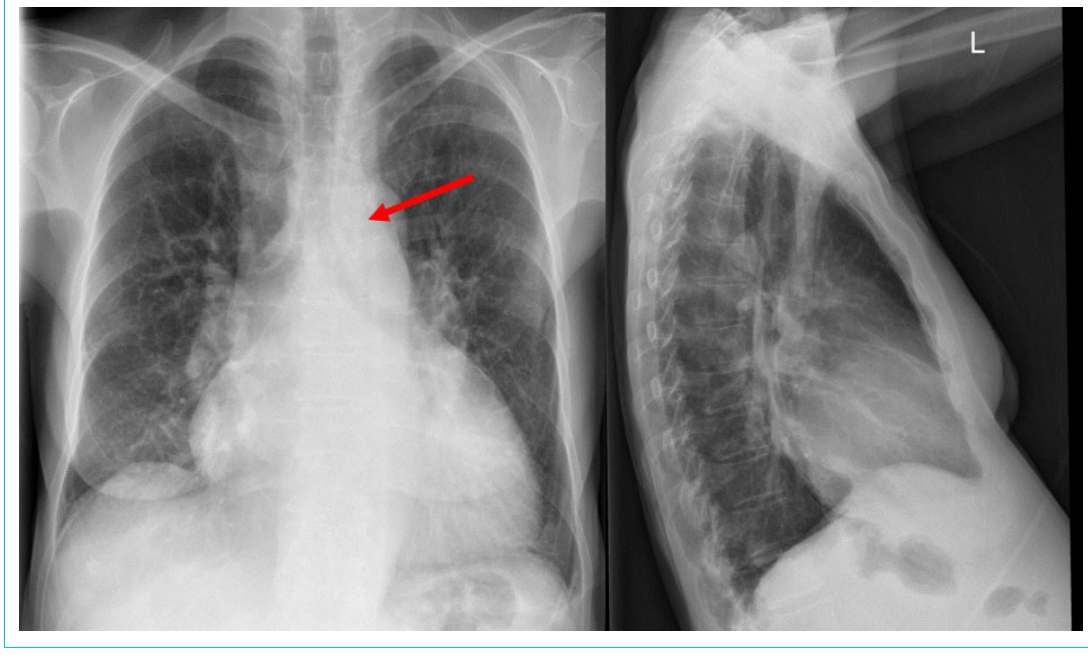
Figure 4: Chest x-ray. Arrow: prominent pulmonary artery. (Courtesy of Prof. T. Frauenfelder.)